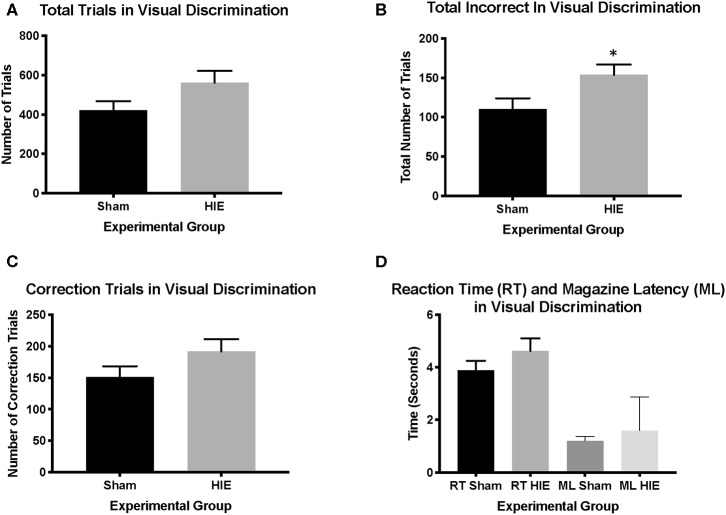
Visual discrimination revealed more incorrect trials in the HIE group compared to sham. During visual discrimination, the total number of trials between the sham and the HIE group were not significantly different (A). The HIE group did require significantly more incorrect trials to complete the visual discrimination component compared to sham (B). Although the HIE group had more correction trials during visual discrimination, this was not significant (C). There was no difference in either the reaction time or magazine latency between the two groups during visual discrimination (D) (n = 13–15, *p < 0.05). Data is represented as mean ± standard error of the mean (SEM).